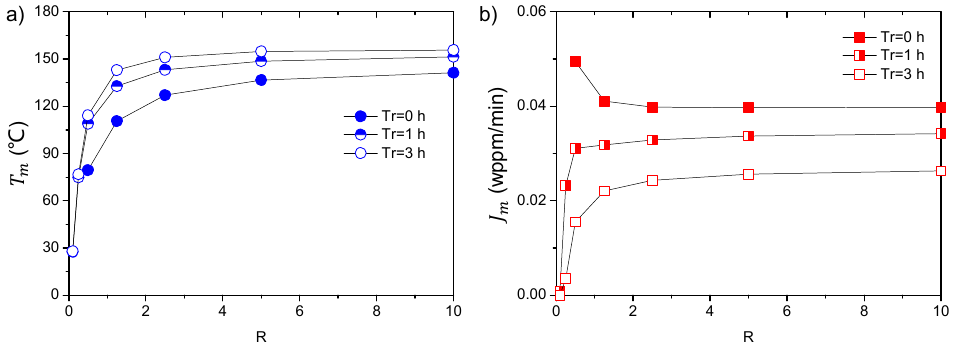
Figure 5. Effect of specimen geometry and rest time on ( a ) the peak temperature and ( b ) the peak flux, using identical parameters to those in Figure 3. For the original desorption spectra with t r = 0 h, the peak temperature decreases but the peak flux increases with specimen dimension.